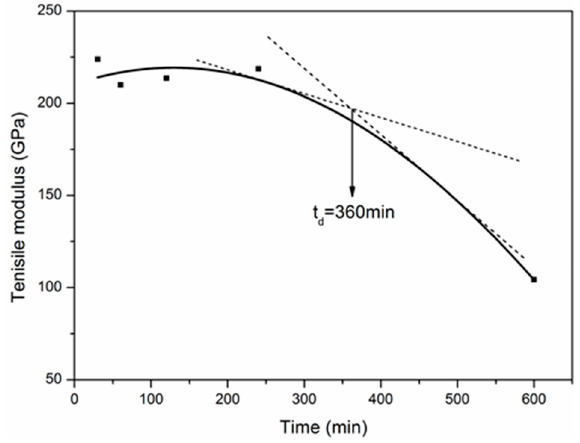
Figure 15. Variation of tensile modulus with the exposure time .